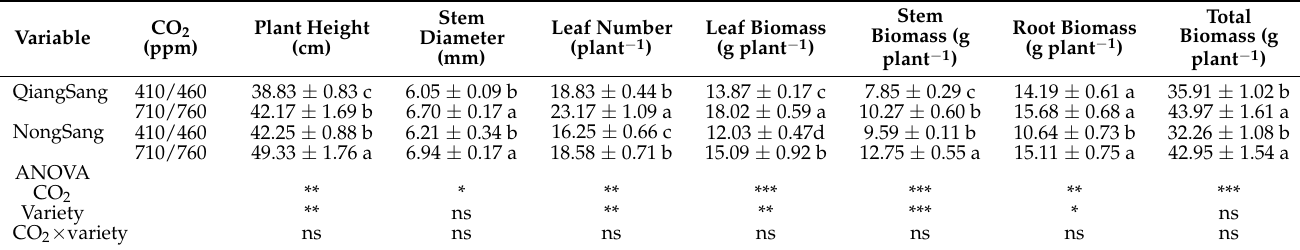
Table 1. Plant growth parameters of two mulberry varieties ( Morus multicaulis Perr. var. QiangSang and NongSang) grown under ambient CO 2 (ACO 2 , 410/460 ppm, daytime/nighttime) and elevated CO 2 (eCO 2 , 710/760 ppm) levels. Data (means ± SE, n = 3) followed by different letters indicate significant differences ( p < 0.05) as revealed by Tukey’s test. ANOVA: ns, not significant; *, ** and *** significant at p ≤ 0.05, p ≤ 0.01 and p ≤ 0.001, respectively.